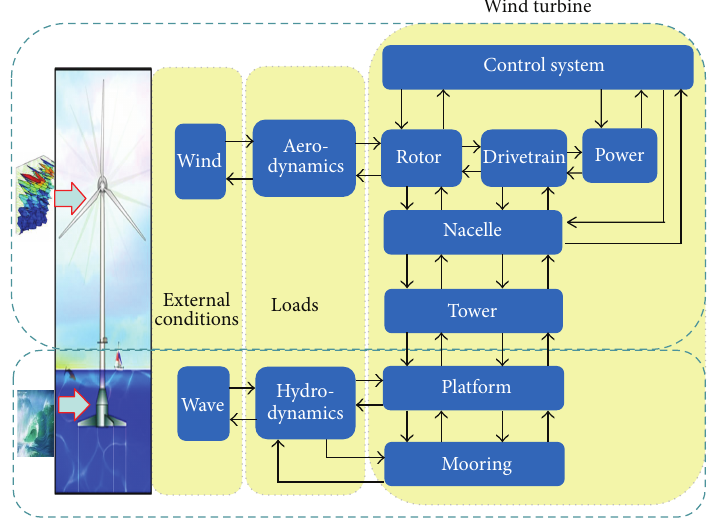
Figure 8: Floating offshore wind power system.